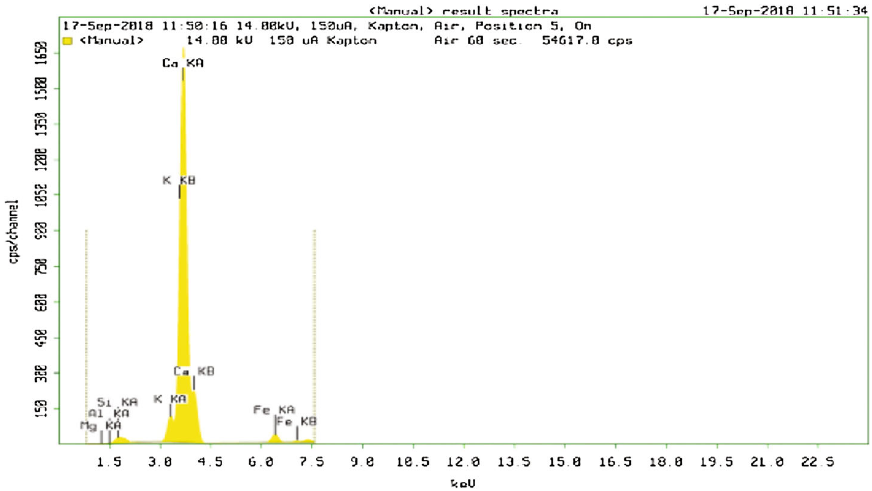
Figure 5: XRF spectra of Ca-rich zeolites.